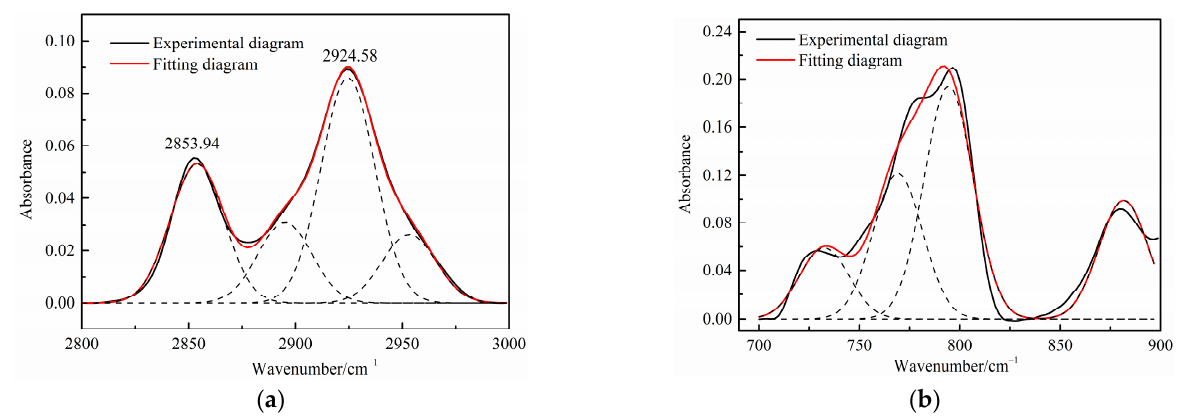
Figure 3. Curve-fitted FT-IR spectra of the aliphatic C–H stretching bands and ( a ) aromatic out-of- plane C-H stretching vibration ( b ) of oil shale.